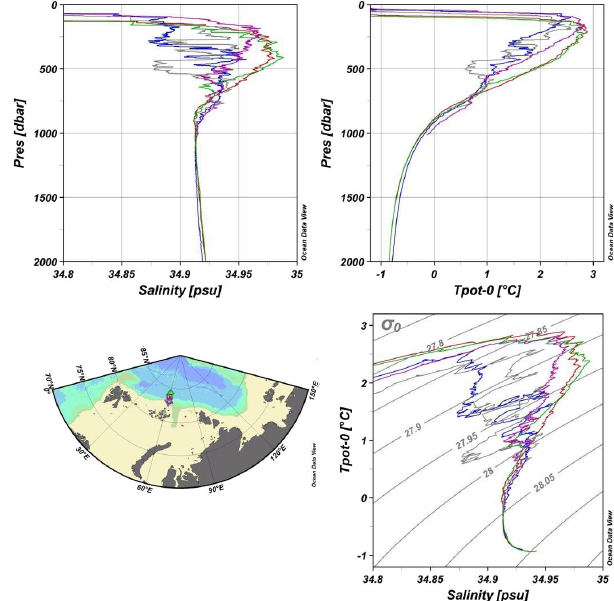
Fig. 6 . Profiles of salinity and potential temperature, and θS curves from the deep stations on the first SPACE section. Notice the colder, less saline Atlantic water and the salinity minimum at 900m at the northern stations and the deep (1500m), weak salinity minimum closer to the slope (better seen in the θS diagram).